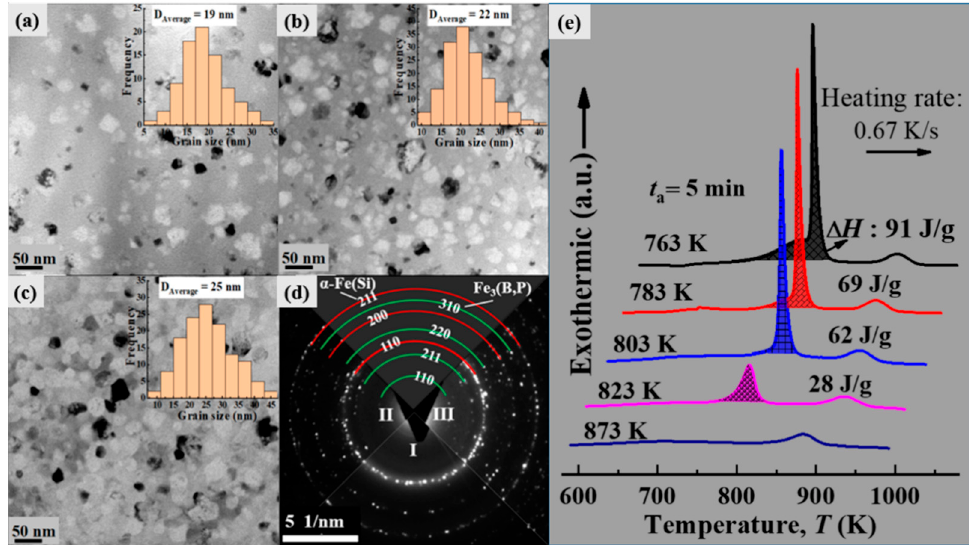
Figure 5. TEM bright field images and grain size distribution for the (Fe 0.76 Si 0.09 B 0.1 P 0.05 ) 98.8 Nb 0.5 Cu 0.7 alloy annealed for 5 min under the following: ( a ) 783 K, ( b ) 803 K, and ( c ) 823 K; ( d ) SAED patterns I, II, and III corresponding to 783 K, 803 K, and 823 K, respectively; and ( e ) DSC curves of the annealed ribbons.